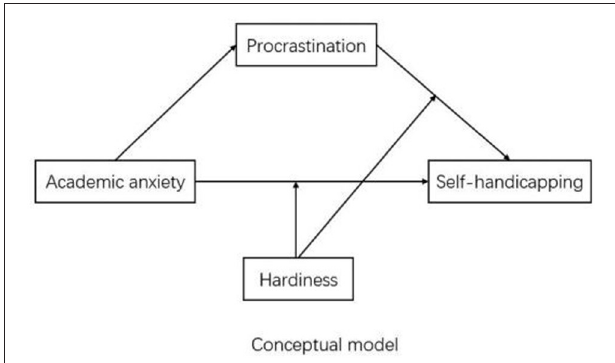
FIGURE 1 | Conceptual